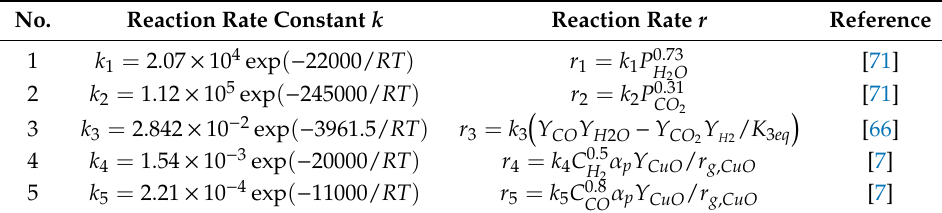
Table 1. Rate parameters of the heterogeneous reactions occurred in the fuel